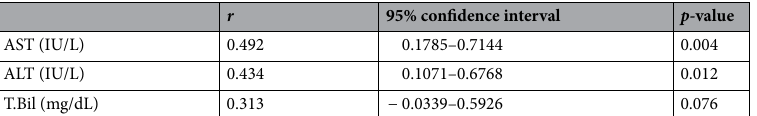
Table 2. Hepatic function test values during treatment and pazopanib plasma trough concentrations. Statistical tests were compared using univariate correlation analysis ; r represents Pearson’s correlation coefficient. AST, Aspartate aminotransferase; ALT, Alanine aminotransferase; T.Bil, Total bilirubin.